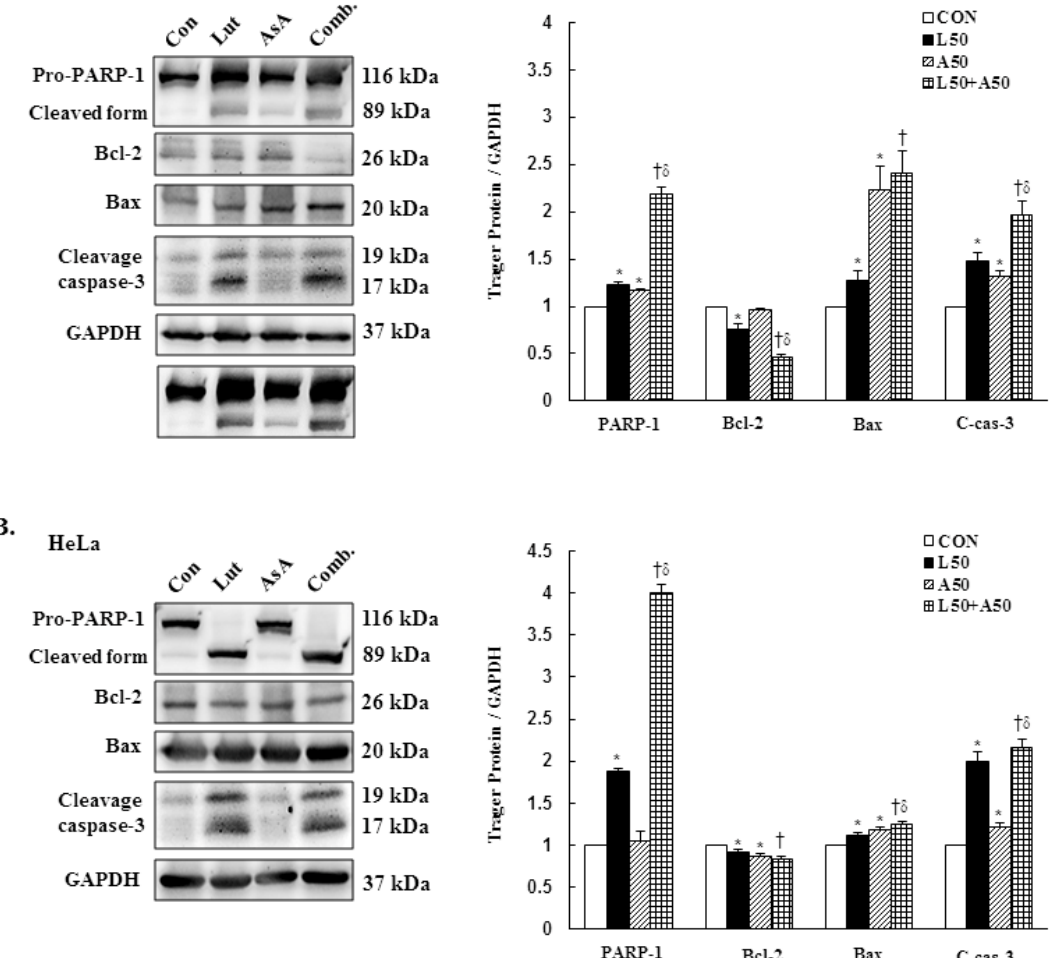
Figure 6. Luteolin combined with asiatic acid induced apoptosis through the mitochondrial-relative intrinsic pathway. Western blotting was used to detect the levels of apoptosis-related proteins, PARP-1, Bcl-2, Bax and caspase-3, in CaSki ( A ) and HeLa ( B ) cells treated with Lut (50 µ M) or AsA (50 µ M) alone or in combination for 24 h. GAPDH served as the loading control. Quantitative results are shown in the lower plot. Values represent mean ± SD from three replicates. *, † and δ p < 0.05 compared with CON, L50- or A50-treated group. CON, 0.1% DMSO; L50, 50 μ M luteolin; A50, 50 μ M asiatic acid; Comb., 50 μ M luteolin + 50 μ M asiatic acid.